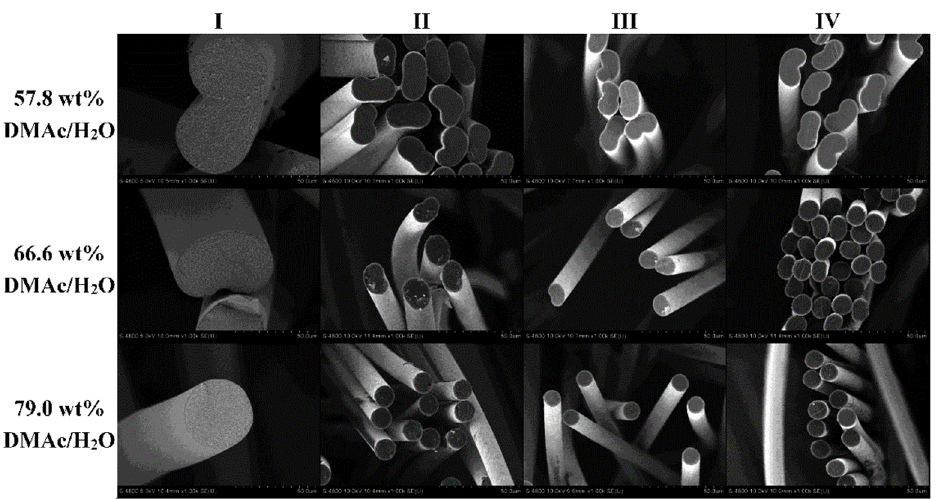
Figure 10. Effects of coagulation bath composition at approximately 19 °C on fiber shape and size as the fiber progresses down the spinning line [90] . the fiber progresses down the spinning line